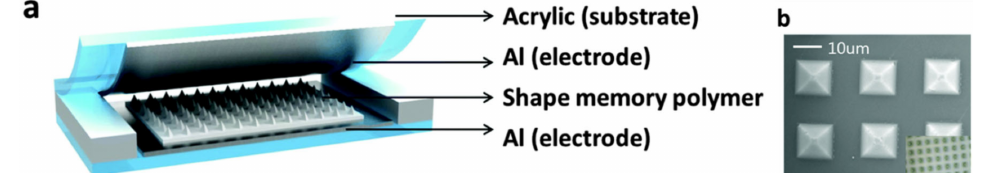
Figure 61. ( a ) Diagram of the structure of TENG. ( b ) Pyramidal pattern of PU on the triboelectric layer of PU. Reproduced from [256] with permission from The Royal Society of Chemistry.